Question: What direction does the quantity move in — increasing or decreasing?
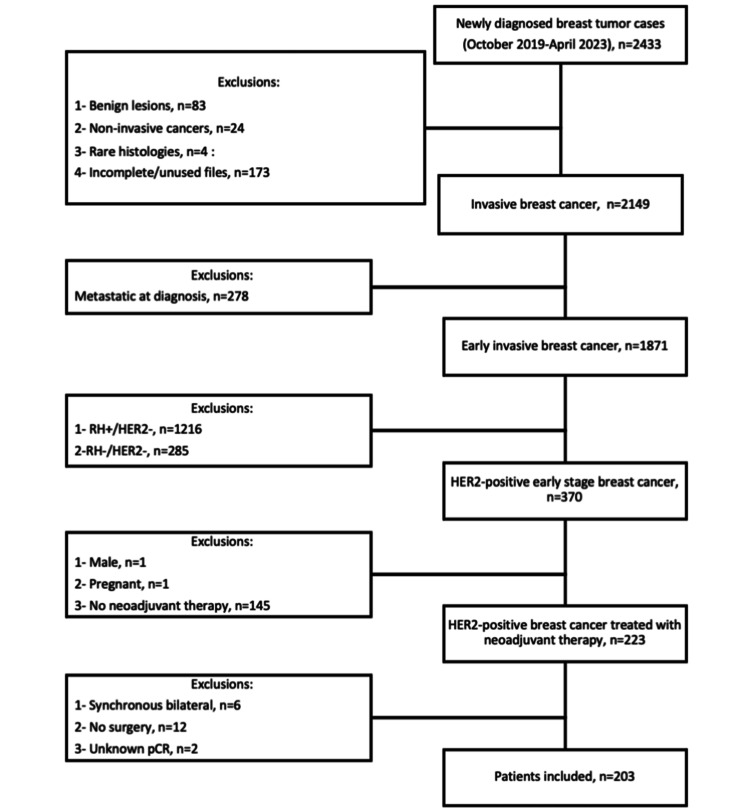
Answer: increasing